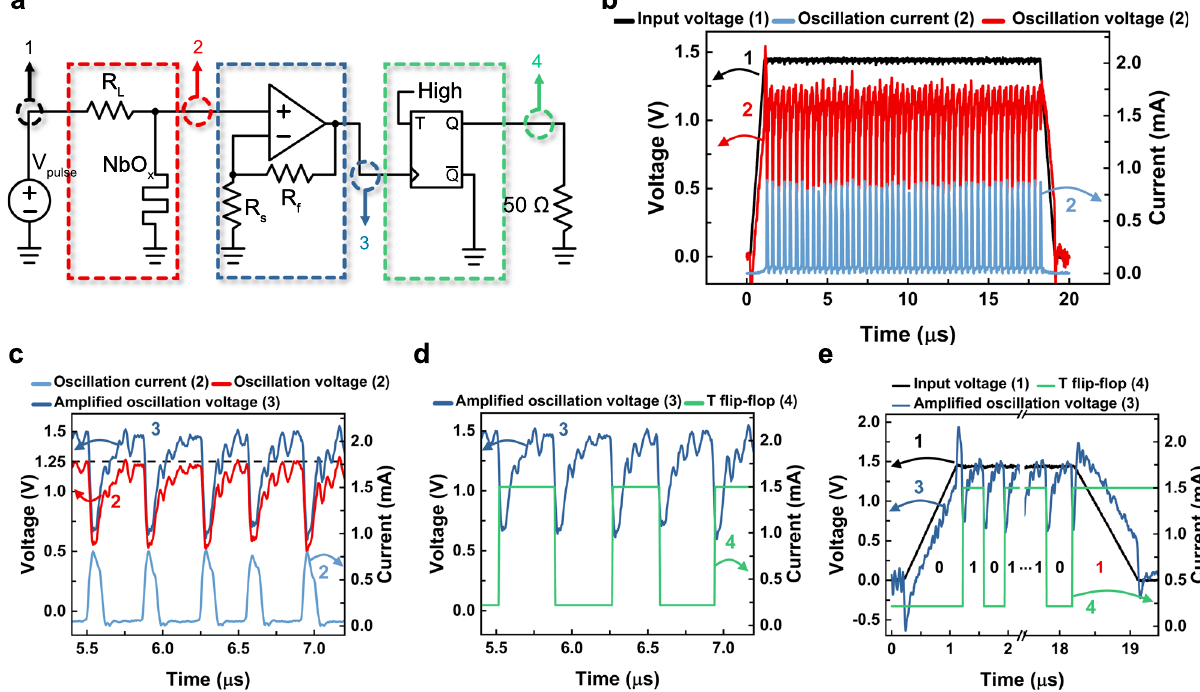
Fig. 3 A TRNG circuit and its simulation. a The proposed TRNG circuit composed of an input voltage source ( V pulse ), a TS oscillator part (red square), a non-inverting ampli fi er part (blue square), and a negative edge triggered T fl ip- fl op (green square). b The input voltage pulse (black) at node 1 and the output voltage (red) and current (bright blue) at node 2. c The ampli fi ed oscillation voltage at node 3 (blue) compared with the output voltage (red) and current (bright blue) at node 2. The horizontal line at 1.25 V indicates the required clock ’ s peak voltage for T fl ip- fl op operation. d The output current at node 4 (green) with respect to the ampli fi ed oscillation voltage as a clock of the T fl ip- fl op. e The input voltage at node 1, the ampli fi ed voltage at node 3, and the output current at node 4 during the entire time frame for generating one random bit. In this case, the random output is